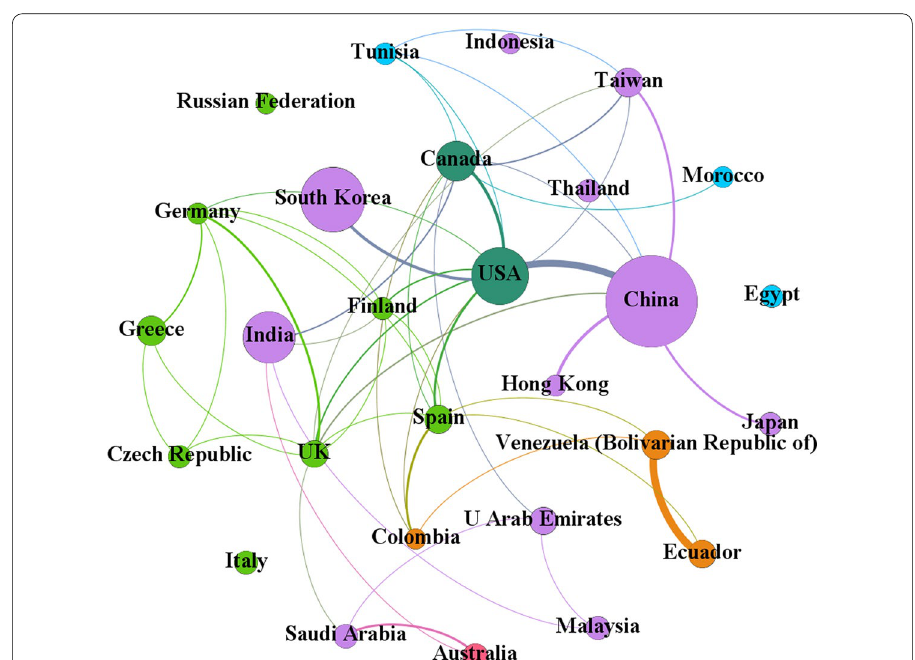
Fig. 5 Collaboration network of top prolific countries/regions (publication count >